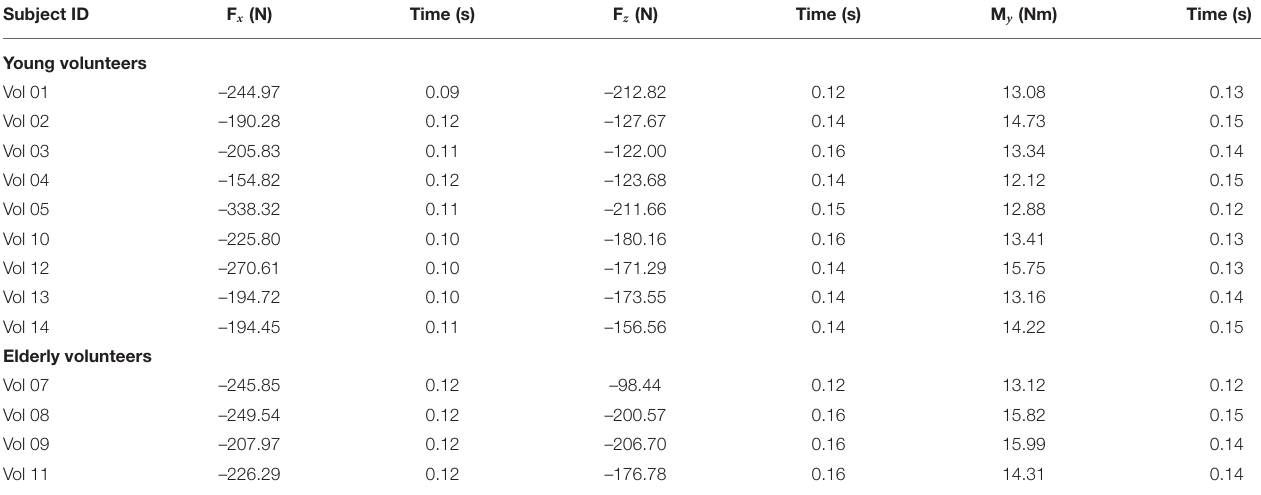
TABLE 6 | Peak upper neck